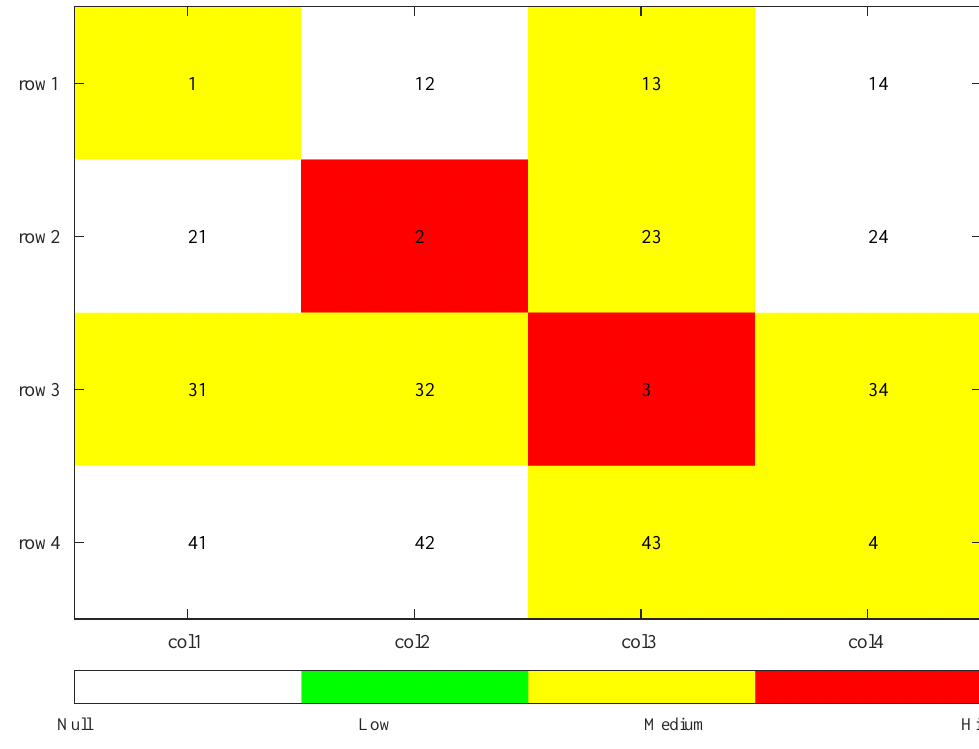
Figure 5. Risk map at the control